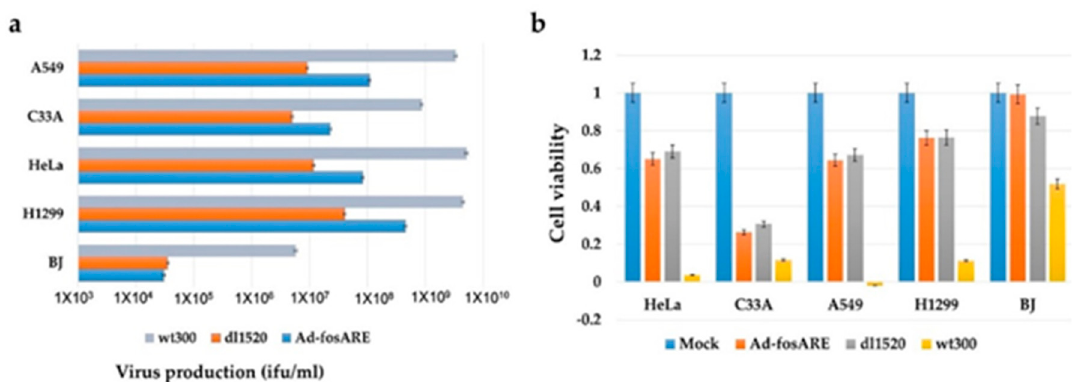
Figure 4. Comparison of the virus production and cell lysis activity of Ad- fos ARE, dl1520 and WT300. ( a ) Cancer cells (HeLa, C33A, A549, and H1299) and normal cells (BJ) were infected with Ad- fos ARE, WT300, and dl1520 at MOI of 10 ifu / cell. Virus production was assessed 48 h after infection. Each titer (ifu / ml) is shown on the graph. ( b ) Cell viabilities were estimated 7 days post-infection by XTT assay. Data presented here are mean ± standard deviations of three independent experiments.